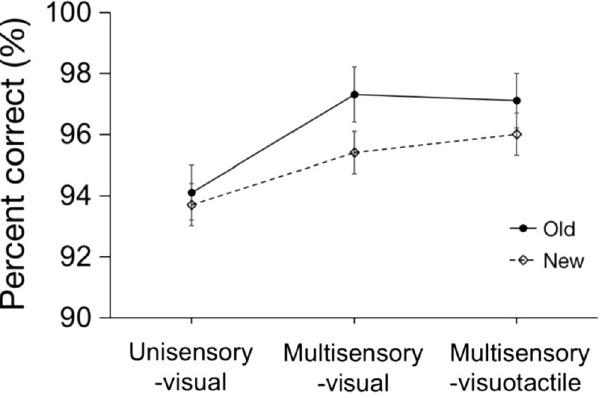
Figure 4. Mean percent correct for old and new configurations on unisensory-visual, multisensory-visual, and multisensory-visuotactile trials. Error bars depict the standard errors of the means